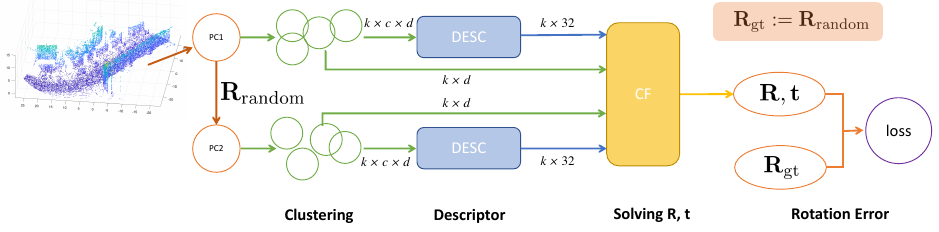
Figure 2. Pipeline of training: single input point cloud; branching with random rotation; clustering (sampling and grouping); descriptor; CF layer to solve for R , t and rotation error as the loss